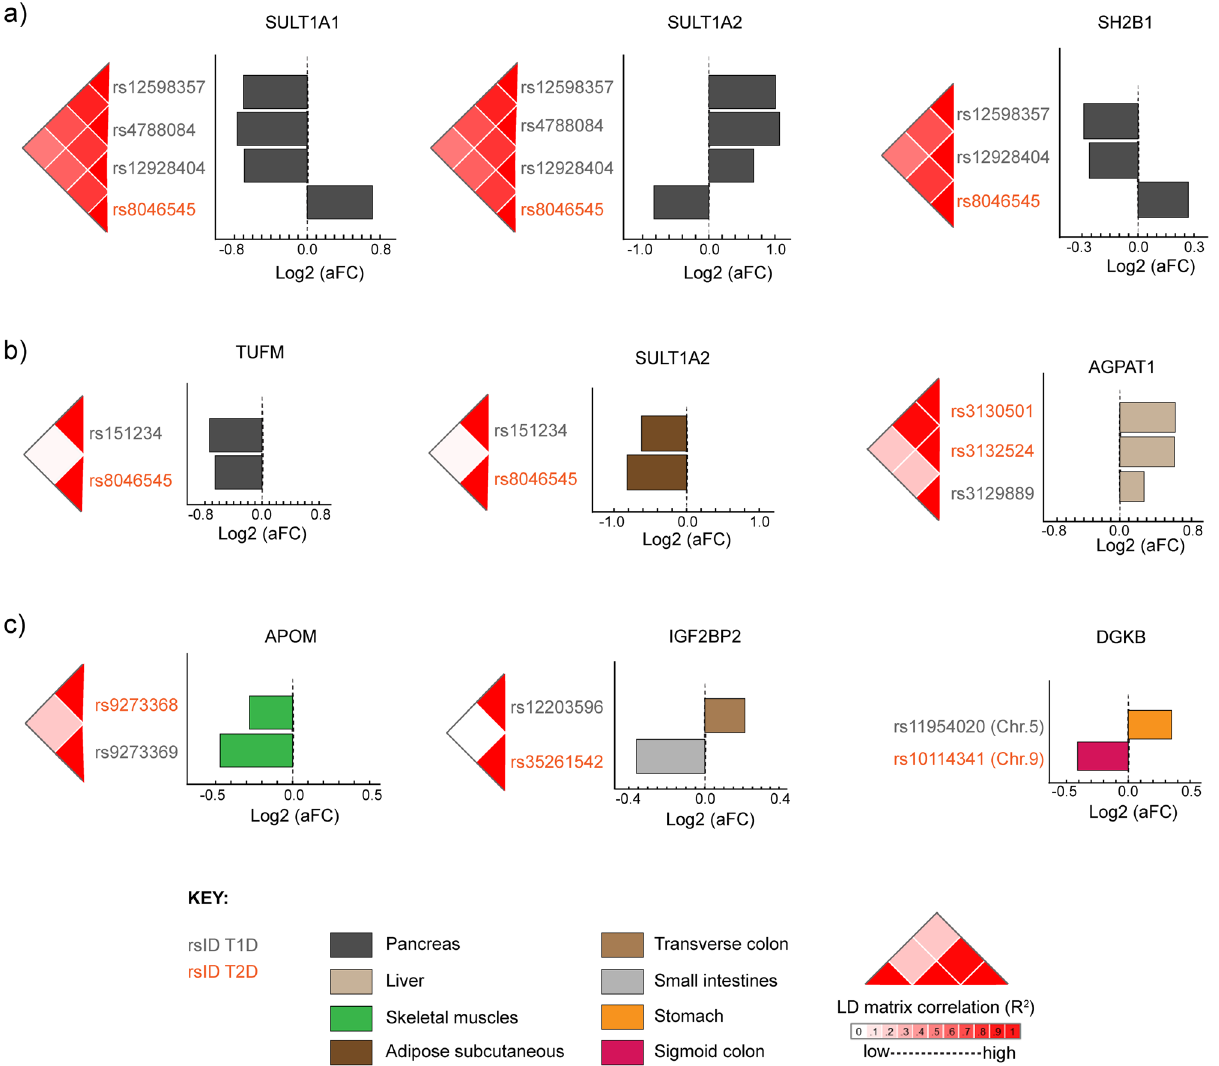
Figure 5. T1D and T2D eQTLs have tissue-dependent effects across human tissues. ( a ) T1D and T2D cis - eQTLs are associated with spatial regulation of shared genes in the pancreas but in opposite directions. ( b ) T1D and T2D cis -eQTLs have similar eQTL effects on shared genes across tissues. ( c ) Trans-eQTLs have mixed effects on transcript levels of shared genes across tissues. aFC—allelic fold change, which denotes the direction of eQTL effect [i.e. upregulated (+) or downregulated (−)]. cis-interactions within 1 Mb on the same chromosome; trans-interactions > 1 Mb either on the same chromosome or interactions > 1 Mb on different chromosomes. Linkage matrices between SNPs are based on European population and were obtained from https:// ldlink. nci. nih.